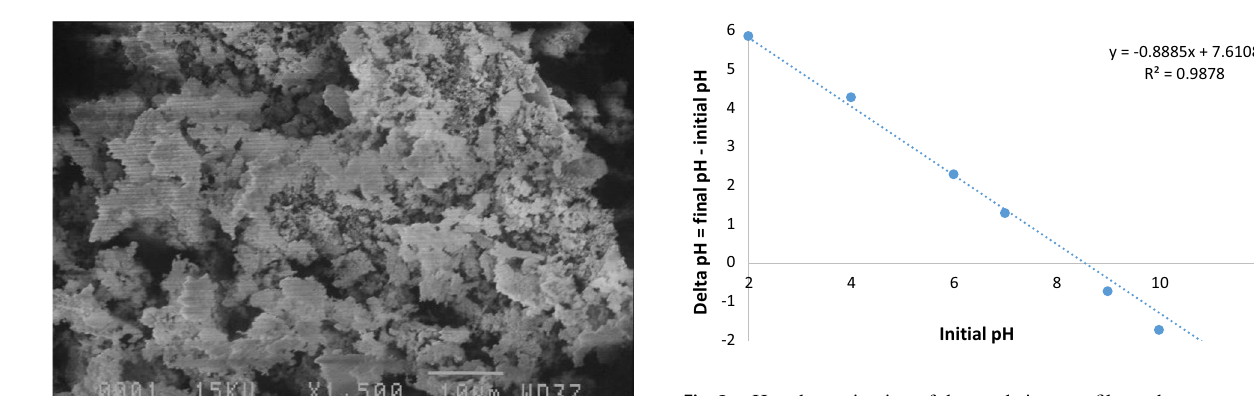
Fig. 3 pH zpc determination of the used cigarette filter